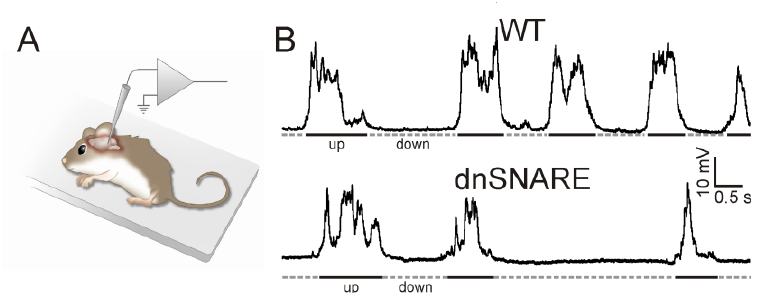
FIGURE 2. The non-neuronal cell astrocyte modulates slow oscillations. (A) Schematic representation of the experimental configuration for in vivo electrophysiological experiments. (B) Representative patch-clamp recordings from a wild-type animal (top) and a transgenic mouse in which a dominant-negative fragment of synaptobrevin 2 is selectively expressed in astrocytes to inhibit gliotransmission (dnSNARE, bottom). Note the reduced frequency and duration of UP-state transitions in transgenic mice compared to controls. Reproduced with permission from Fellin et